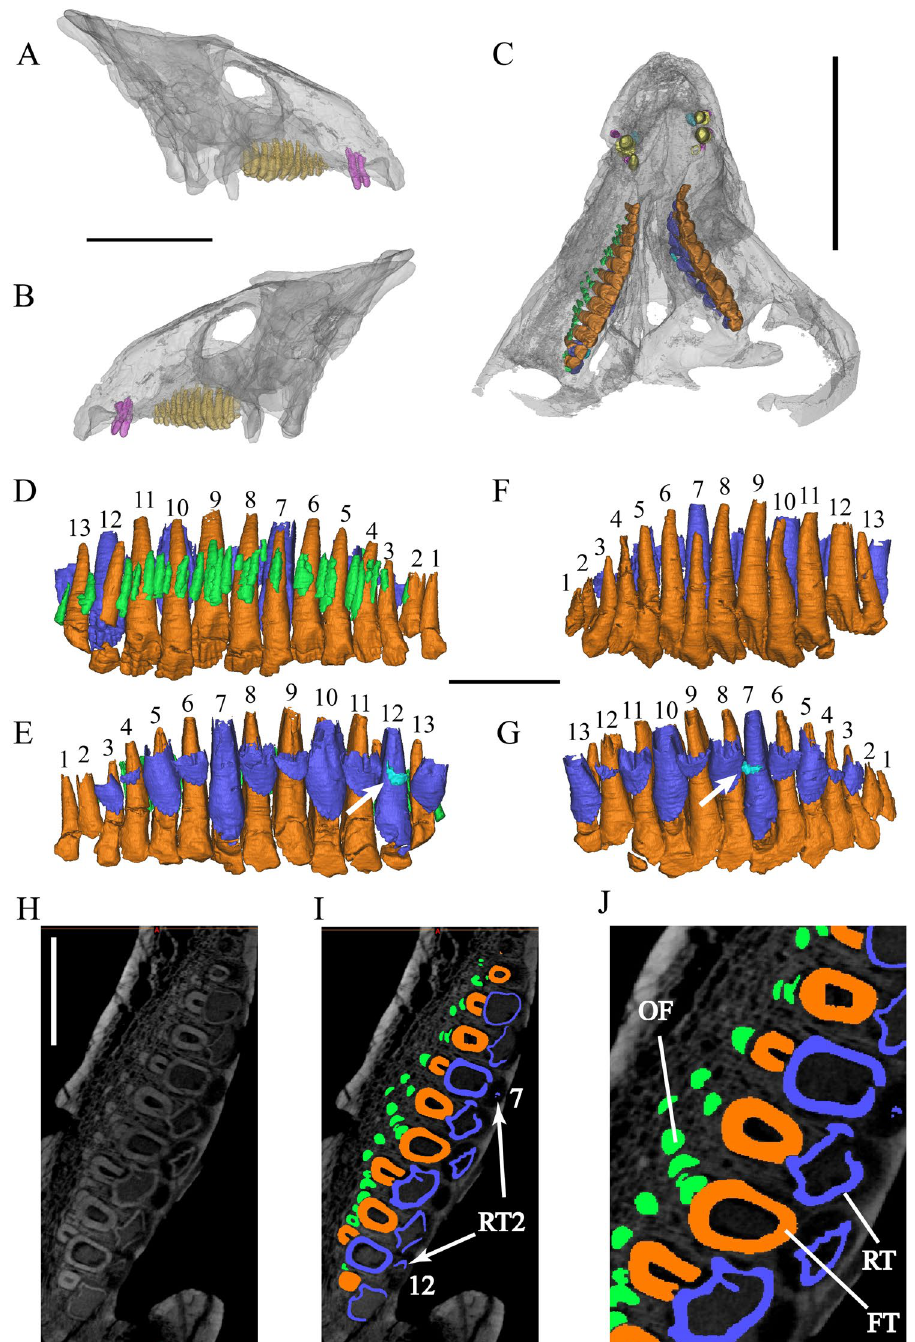
Figure 2. Liaoceratops yanzigouensis , IVPP V12738 (holotype) maxillary teeth. Elements in the CT reconstructions are colour-coded as follows: functional teeth ( A and B ), yellow; functional teeth ( C – J ), orange; 1 st generation replacement teeth, blue; 2nd generation replacement teeth, turquoise; right old resorbed functional teeth, green. ( A , B ) Transparent reconstruction of the skull of IVPP V12738 from 450 kV CT data in lateral view; ( C ) transparent reconstruction of the maxillary teeth portion of IVPP V12738 from 225 kV CT data in ventral view; ( D ) (right), ( F ) (left), reconstructed and extracted maxillary teeth composite in labial view; ( E ) (right), ( G ) (left), reconstructed and extracted maxillary teeth composite in lingual view; ( H – J ) longitudinal CT cross sections through the right maxilla, ( J ) zoomed photograph of I . Numbers indicate tooth positions from mesial to distal. Scale bars equal 50 mm ( A – C ) and 10 mm ( D – J